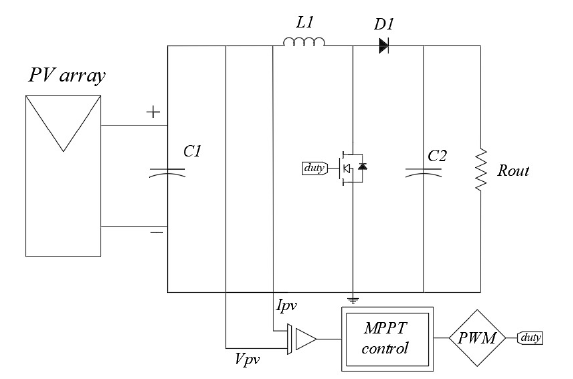
Figure 5. Circuit model used for the implementation of the MPPT-P&O and MPPT-FA